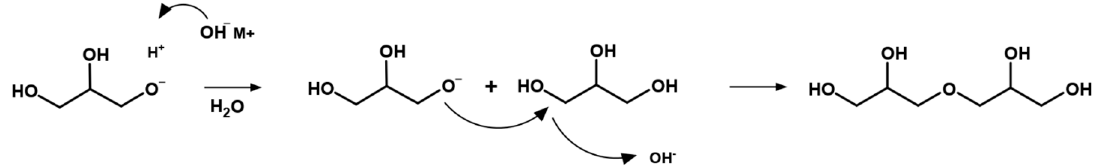
Figure 7. Reaction mechanism for homogenously catalyzed glycerol polymerization reaction, as proposed in [12].